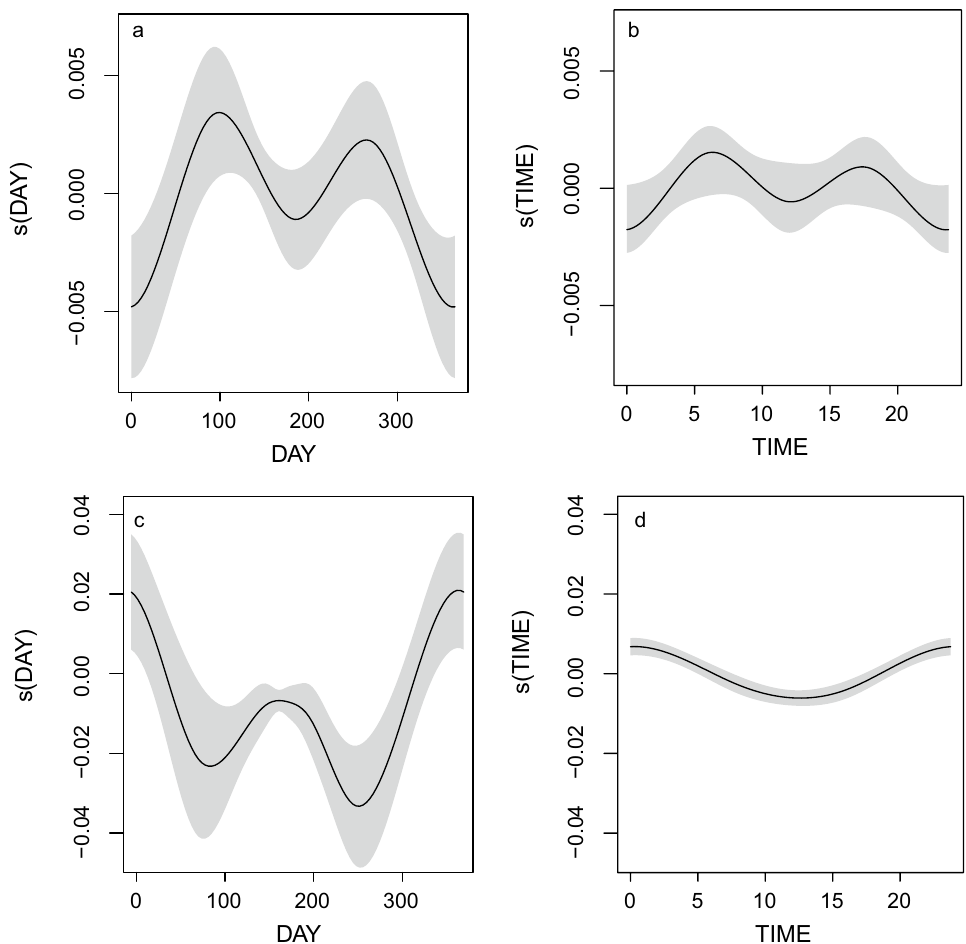
Figure 4. Generalized additive model (GAM) plots showing the partial effects of day of the year and time of day on the frequency of Carcharhinus leucas ( a , b ) and Carcharhinus limbatus ( c , d ) shark detection events at receiver locations throughout the Inhambane province of southern Mozambique. Shaded areas indicate the 95% confidence